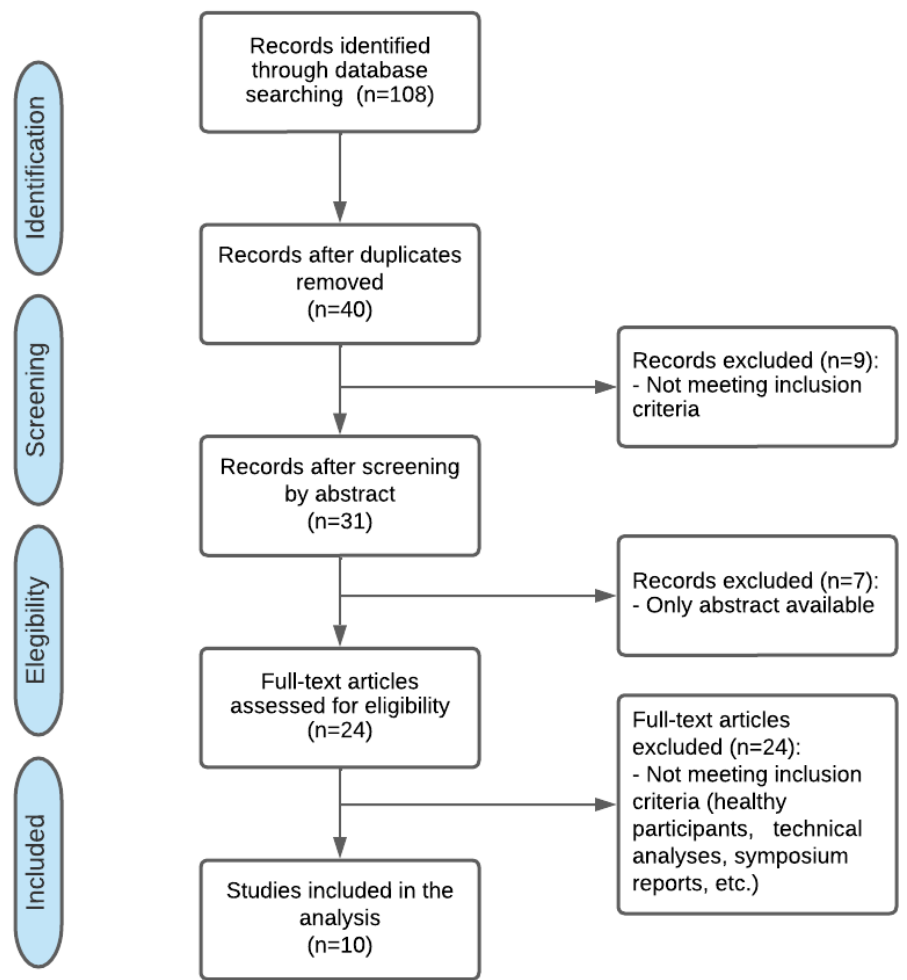
Figure 1. PRISMA Flow chart for identifying studies for systematic review.